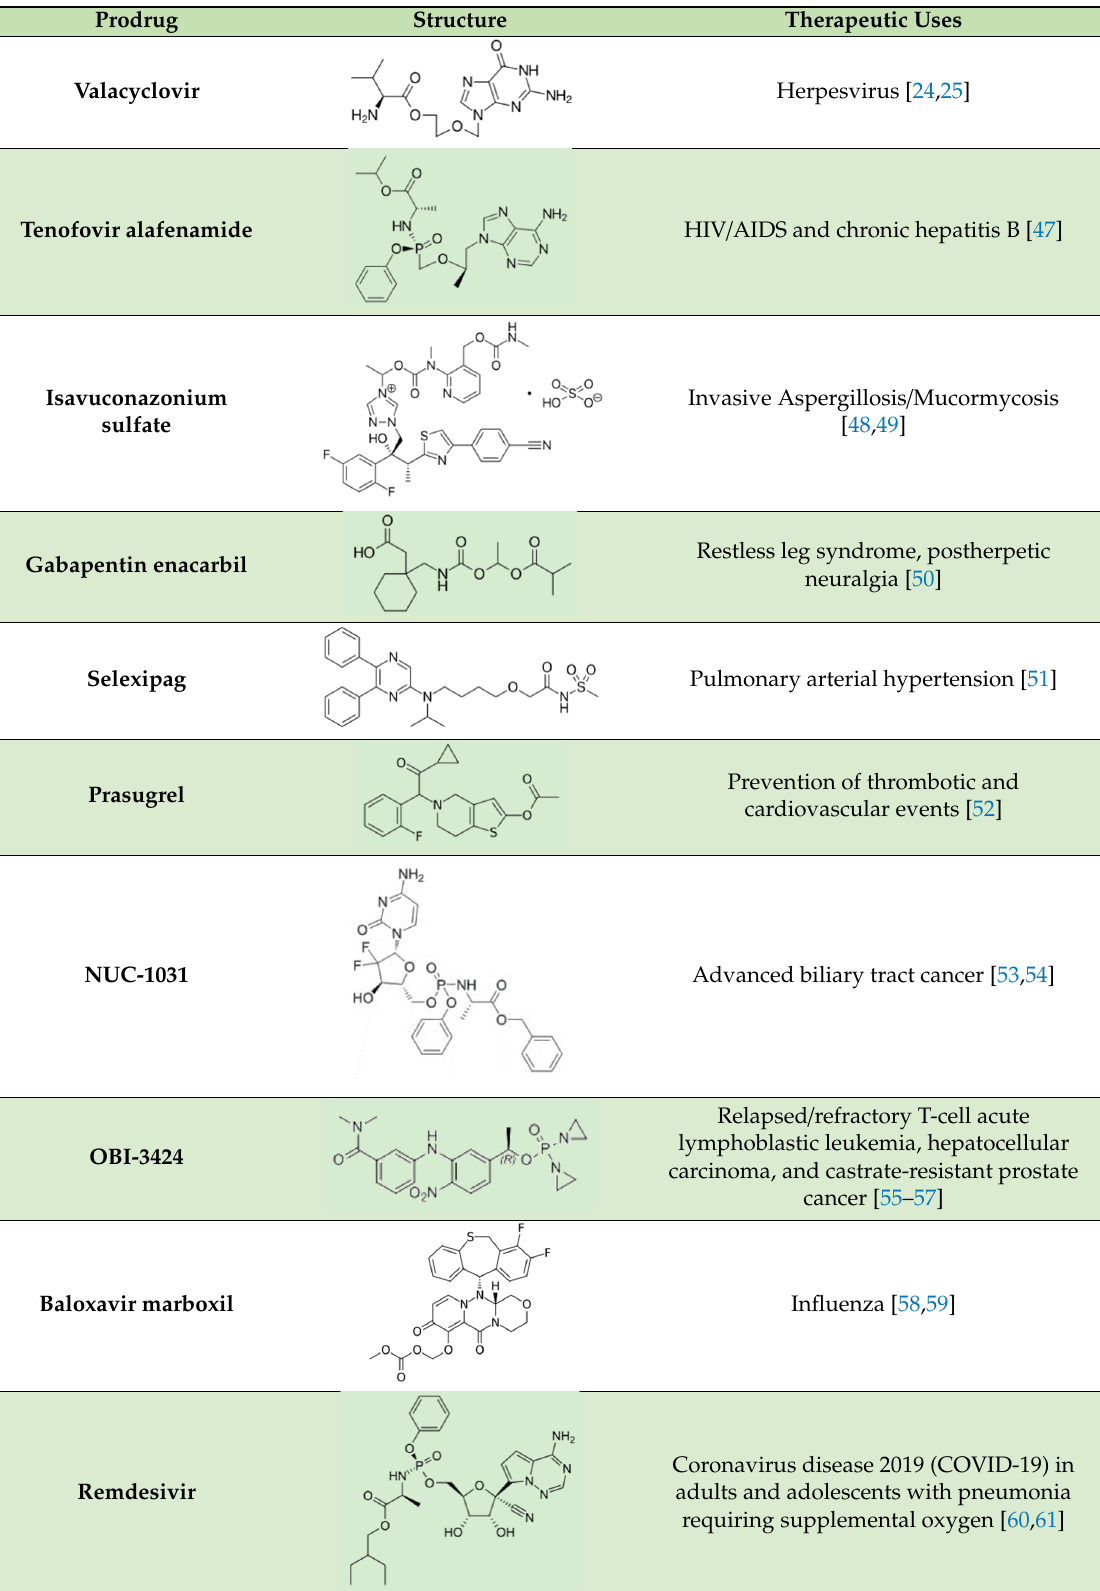
Table 1. Prodrug structures and their therapeutic uses.